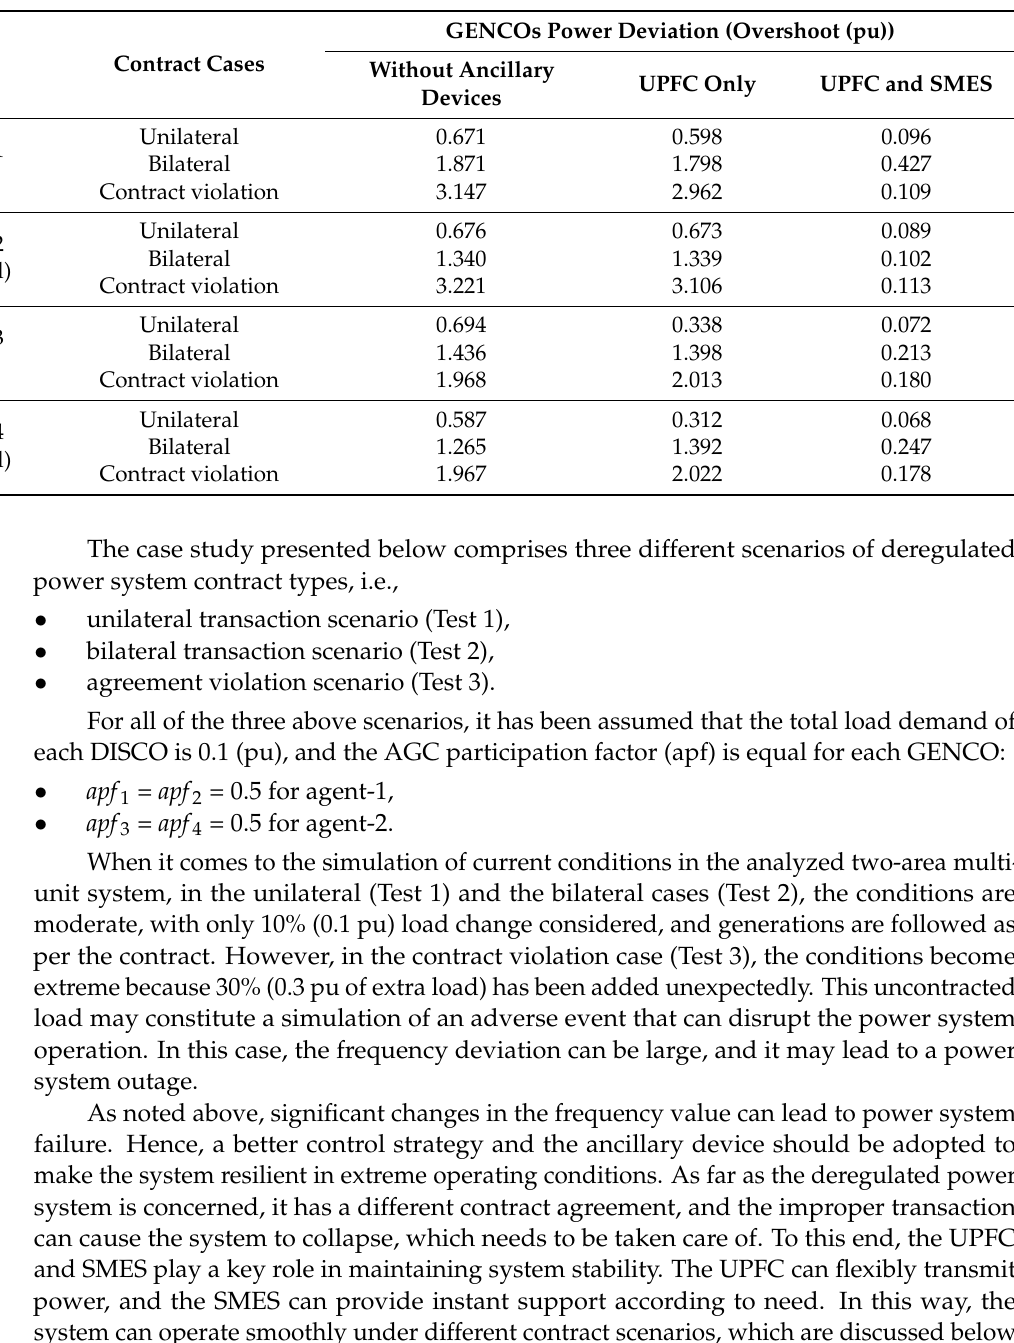
Table 5. Power output deviation for each GENCO according to response characteristics under unilateral, bilateral, and contract violation